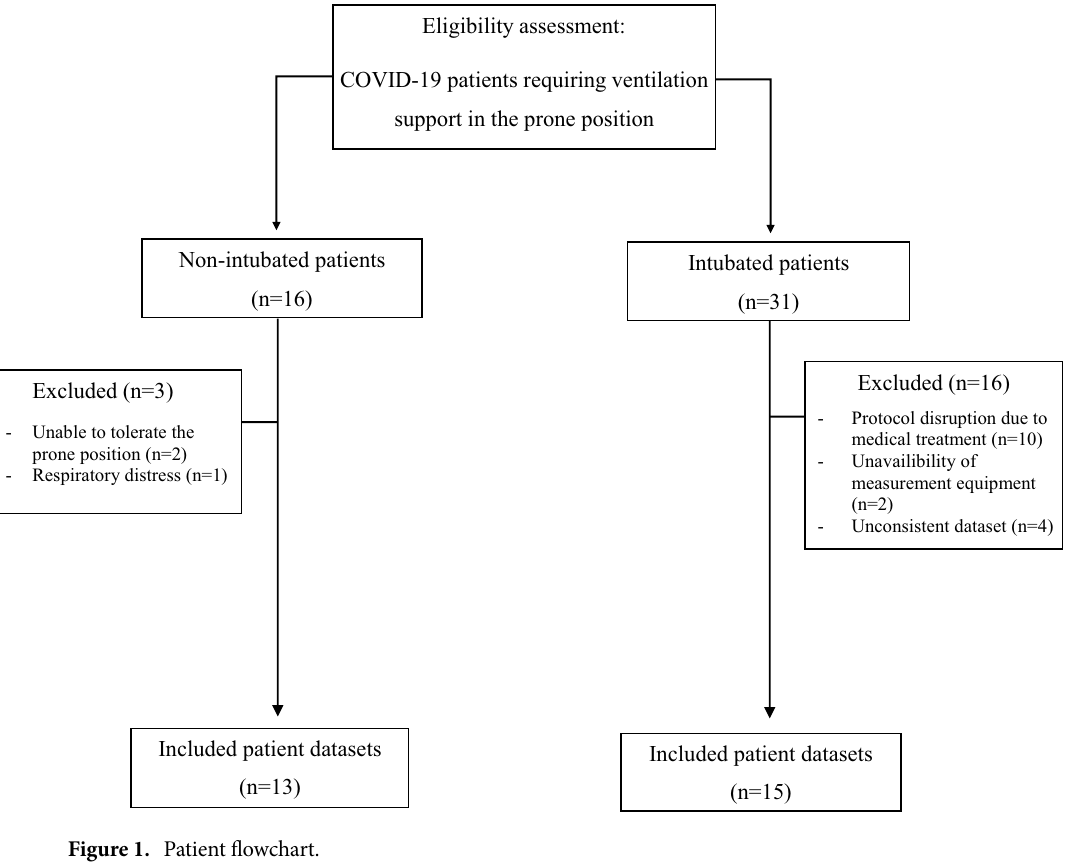
Figure 1. Patient